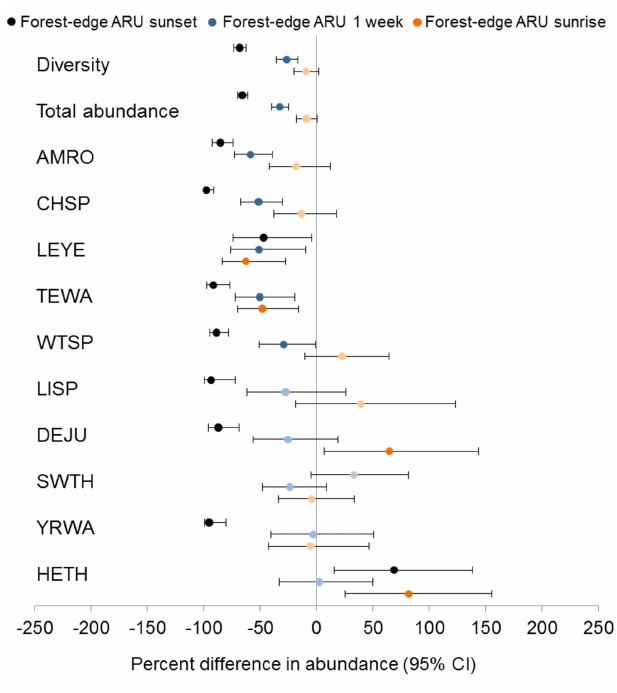
Fig. 3 . Percent difference (95% confidence interval [CI]) in relative abundance in counts from (1) human North American Breeding Bird Survey (BBS) and forest-edge autonomous recording unit (ARU) sunset surveys, (2) human BBS and forest-edge ARU sunrise surveys, and (3) human BBS and forest-edge ARU 1 week earlier surveys. See Figure 2 legend for details. See Results for definitions of